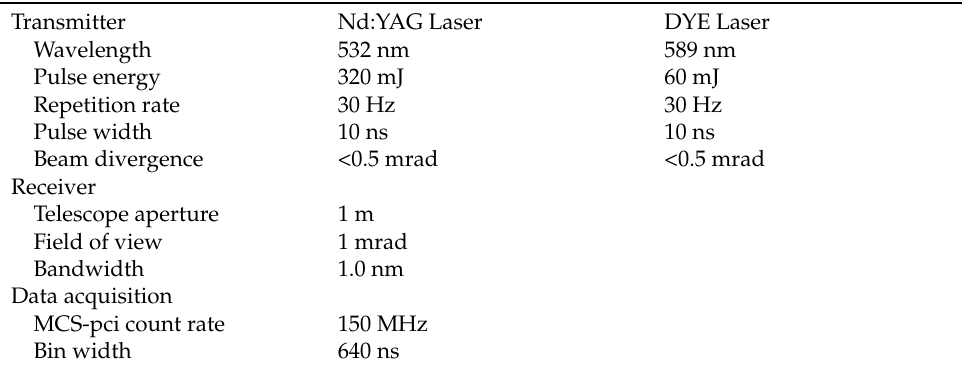
Table 1. Parameters of Rayleigh lidar in